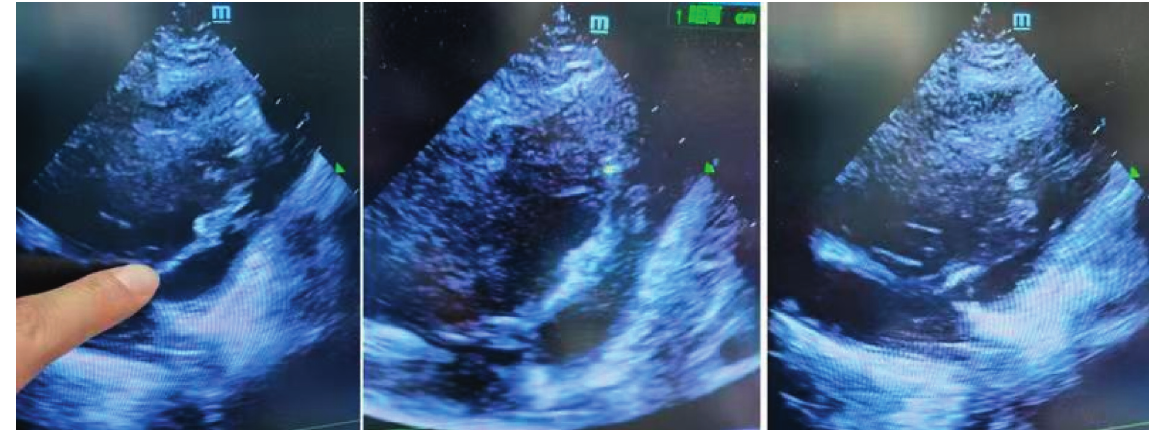
Figure 1: Ultrasonic image of bleeding and thrombus caused by electrode insertion into the myocardium.